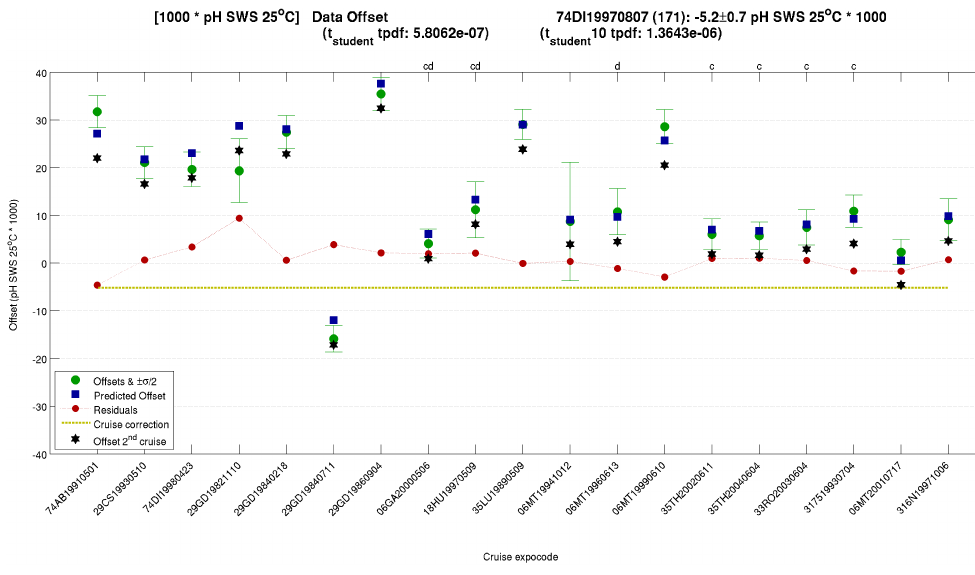
Figure 19. Cruise crossover information plot for 74DI19970807 (171).